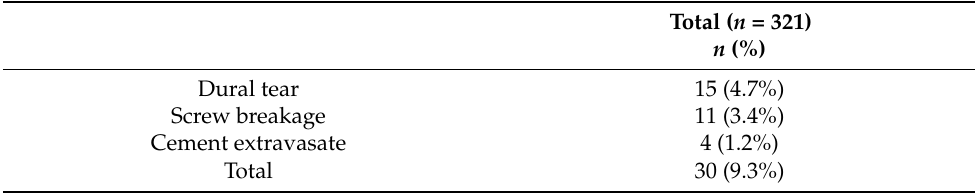
Table 4. Intraoperative complications. n = number.